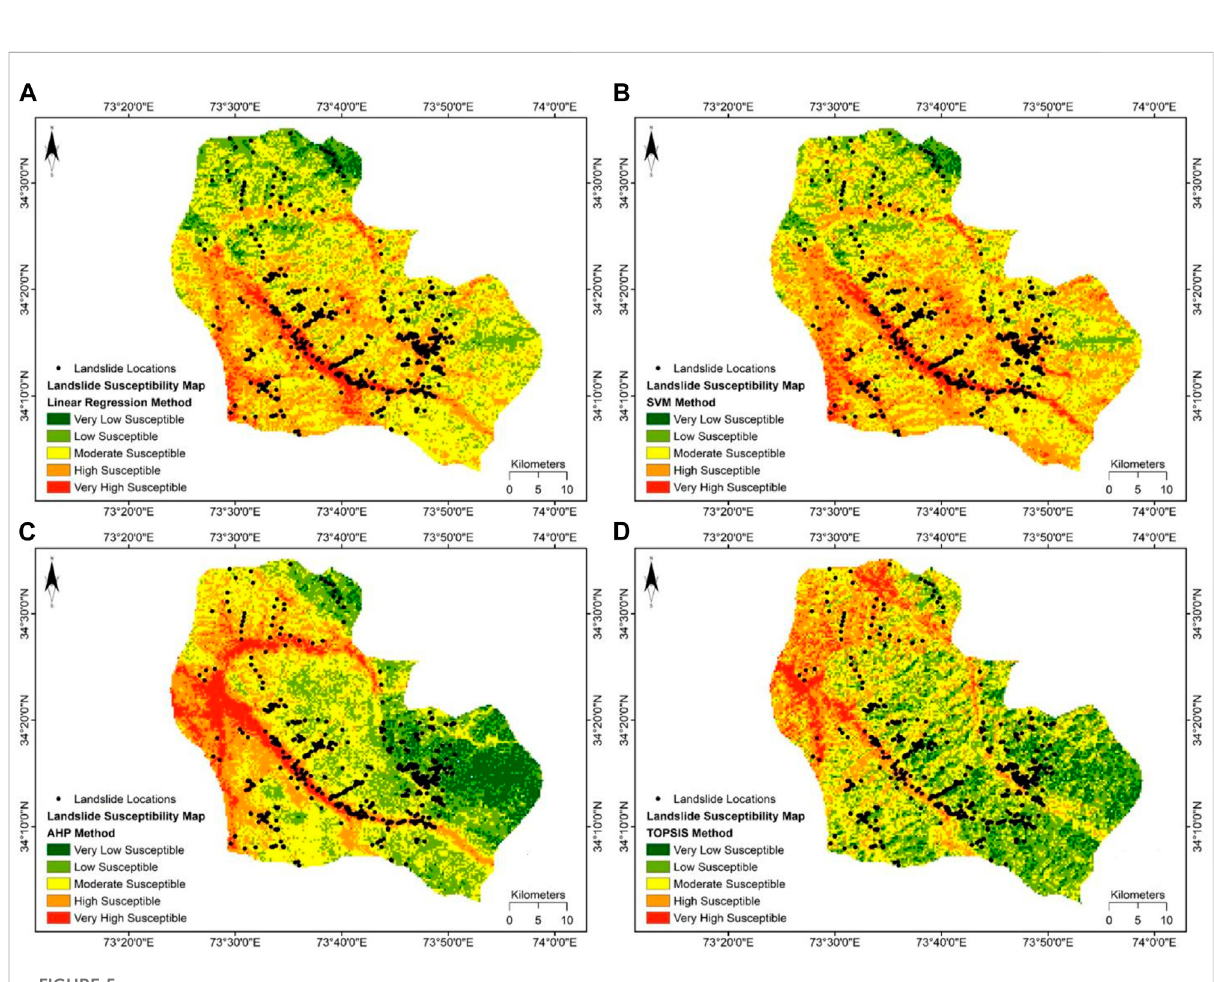
FIGURE 5 Landslide susceptibility maps derived from (A) LR (B) SVM (C) AHP and (D)